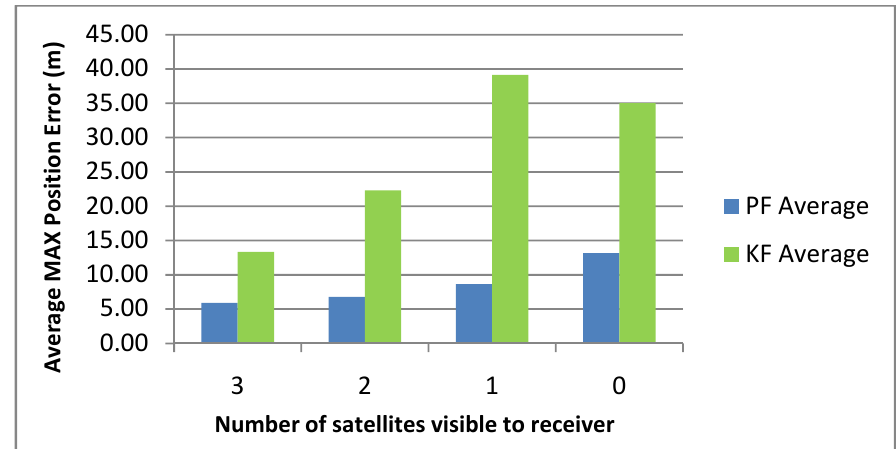
Figure 13. Average maximum position error over the 10 outages in Toronto-Kingston